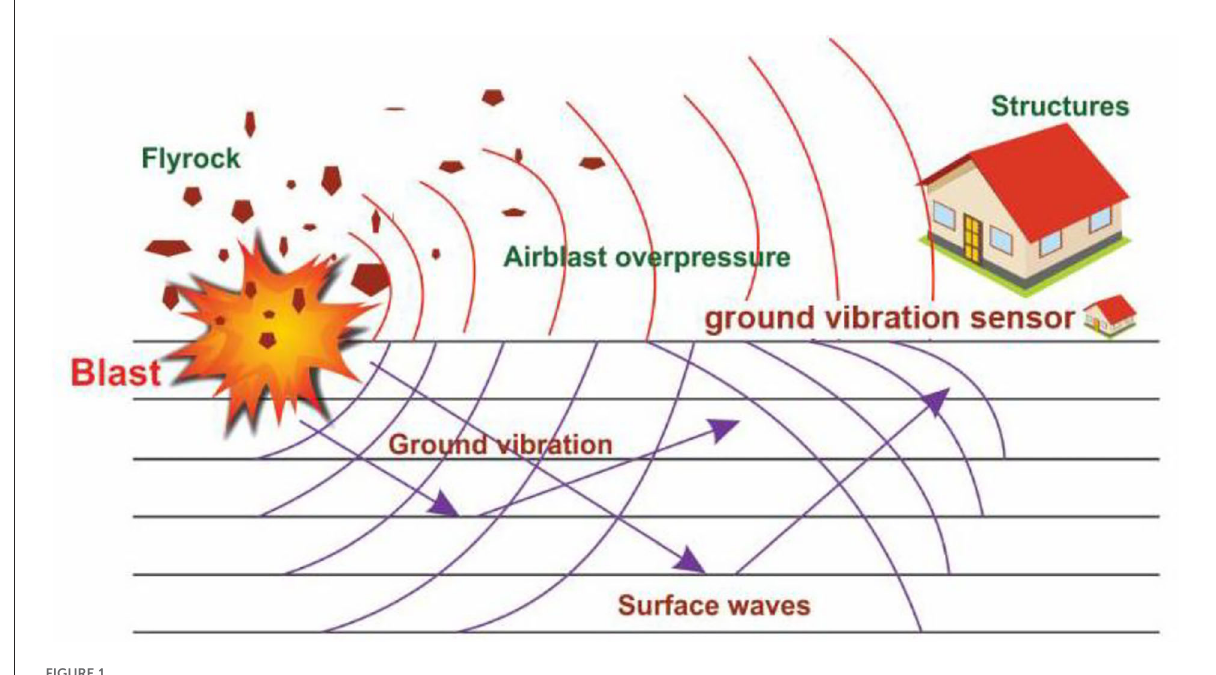
FIGURE1 Phenomena induced by blasting